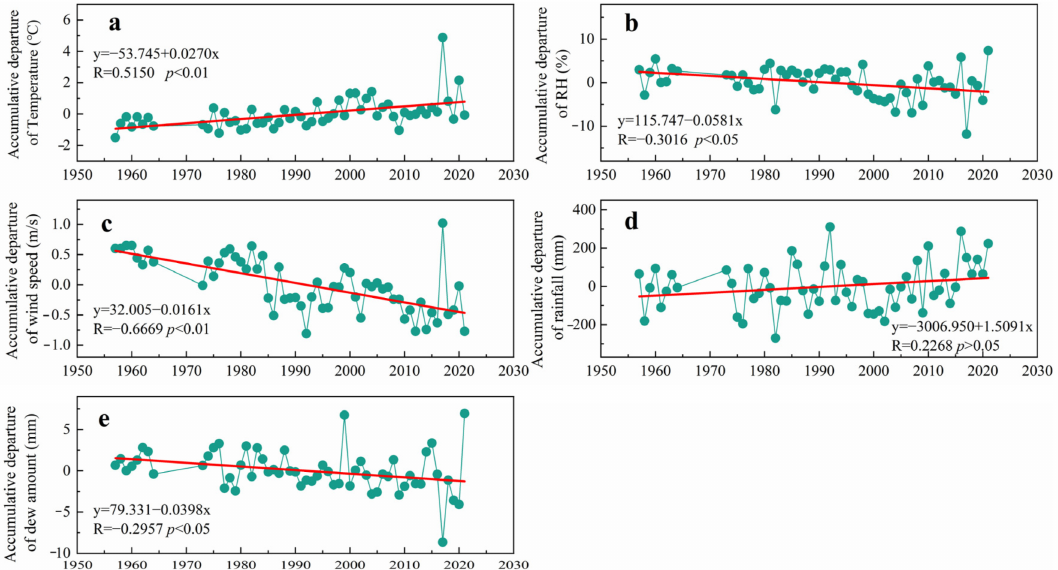
Figure 4. Accumulative departure of meteorological factors (( a ) Temperature; ( b ) RH%; ( c ) wind speed; ( d ) rainfall) and dew amount ( e ) during the dew condensation period in Changchun from 1957 to